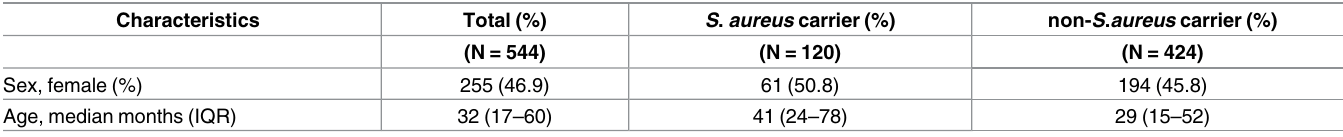
Table 1. Demographic characteristics of study participants.